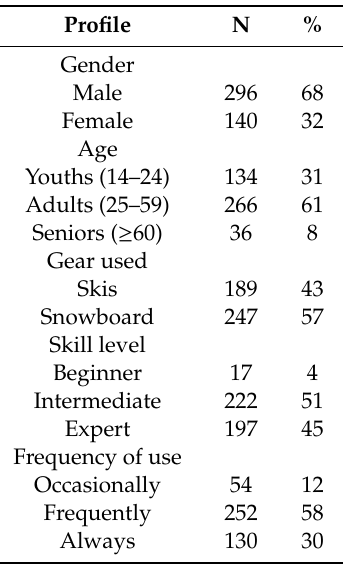
Table 3. Respondents